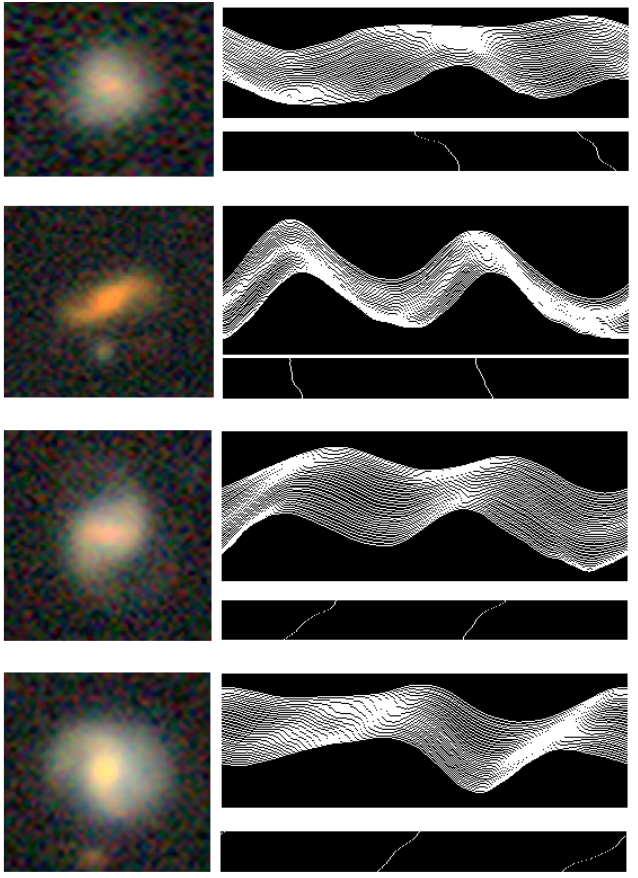
Figure 1. Examples of DES galaxy images and their corresponding radial intensity plots. The peaks detected in the radial intensity plots are displayed below the radial intensity plots. The X-axis is the polar angle of the pixel, and the Y-axis is the radial distance. The directions of the lines formed by the peaks reflect the change in the position of the arm compared to the galaxy center, and therefore reflect the curves of the arms. The direction towards which the arms are curved consequently reflects the spin direction of the galaxy. The algorithm is symmetric, and it is model-driven with intuitive rules. It is not driven by complex non-intuitive data-driven rules commonly used in pattern recognition